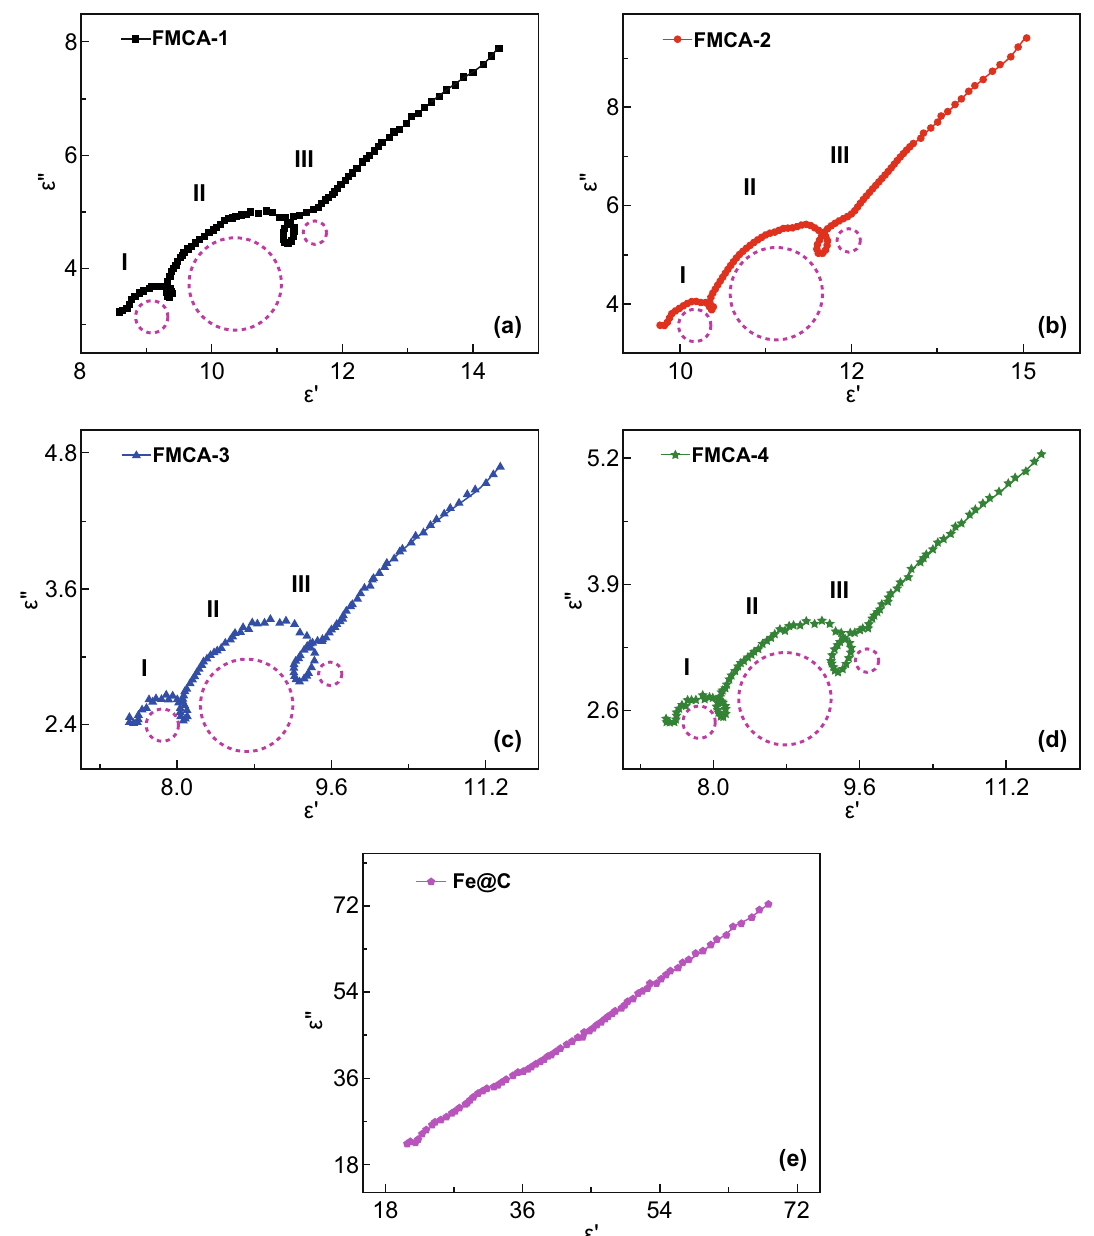
Fig. 7 Cole–Cole curves of a FMCA-1, b FMCA-2, c FMCA-3, d FMCA-4, and e